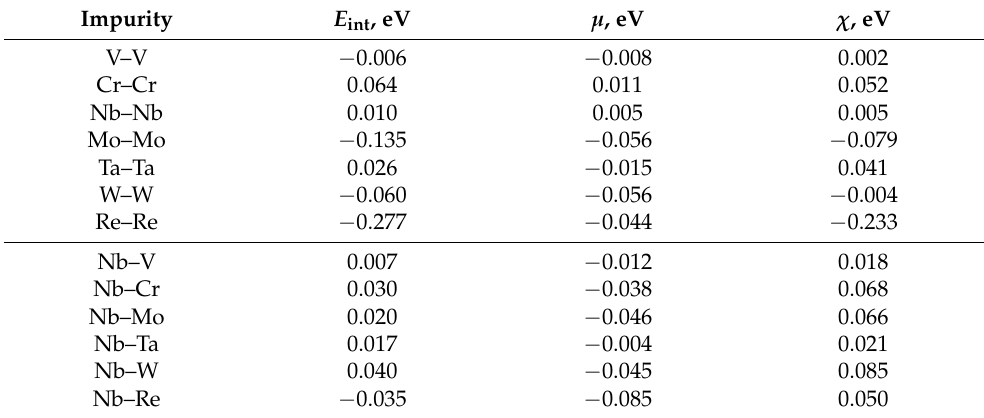
Table 3. Interaction energy ( E int ) between impurity atoms at second neighbor positions, split into mechanical ( μ ) and chemical ( χ ) contributions.